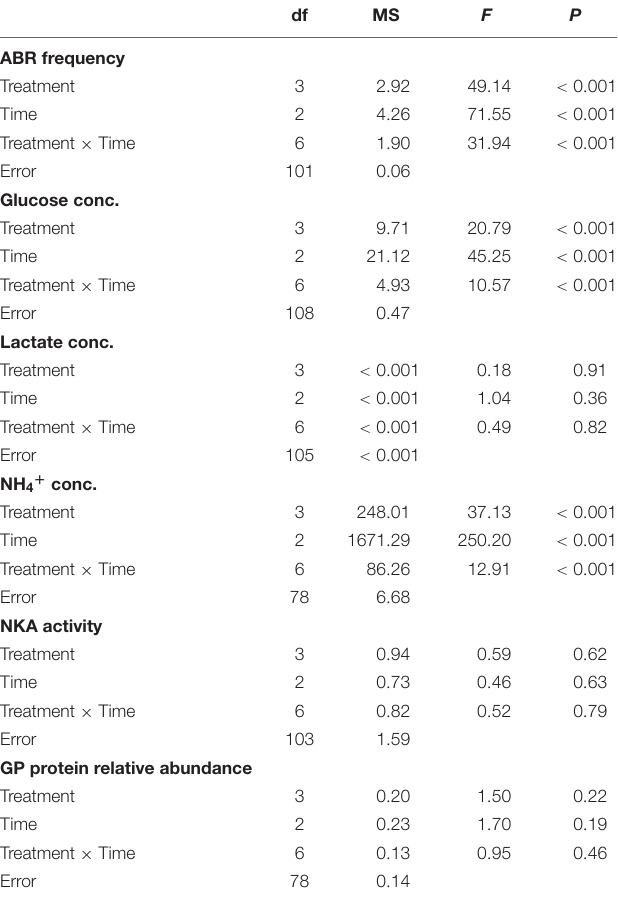
TABLE 3 | The effects of control (C), hypoxic (H), thermal (T), hypoxic-and-thermal (HT) treatments on 0, 2, and 6 h in ABR group based on two-way